Question: Give a one-sentence summary of this figure.
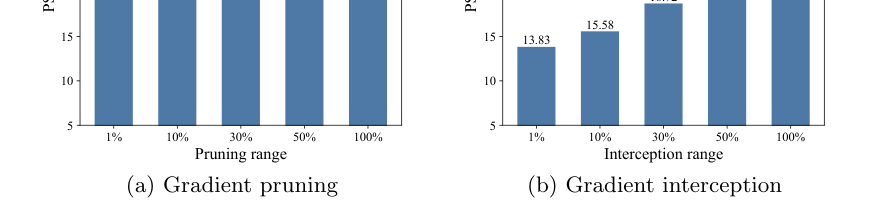
Answer: The impact of gradient pruning and gradient interception on GI-SMN. The horizontal axis indicates the retained gradient information (%).